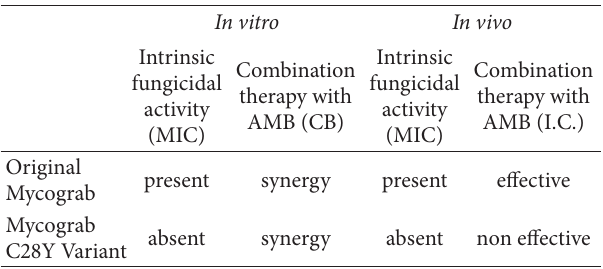
Table 3: In vitro and in vivo final evaluations of the efficacy of Mycograb and its C28Y